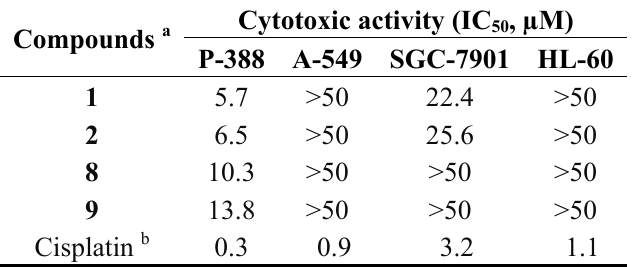
Table 2. Cytotoxic activity of compounds 1 – 9 against four cancer cell lines in vitro . Compounds